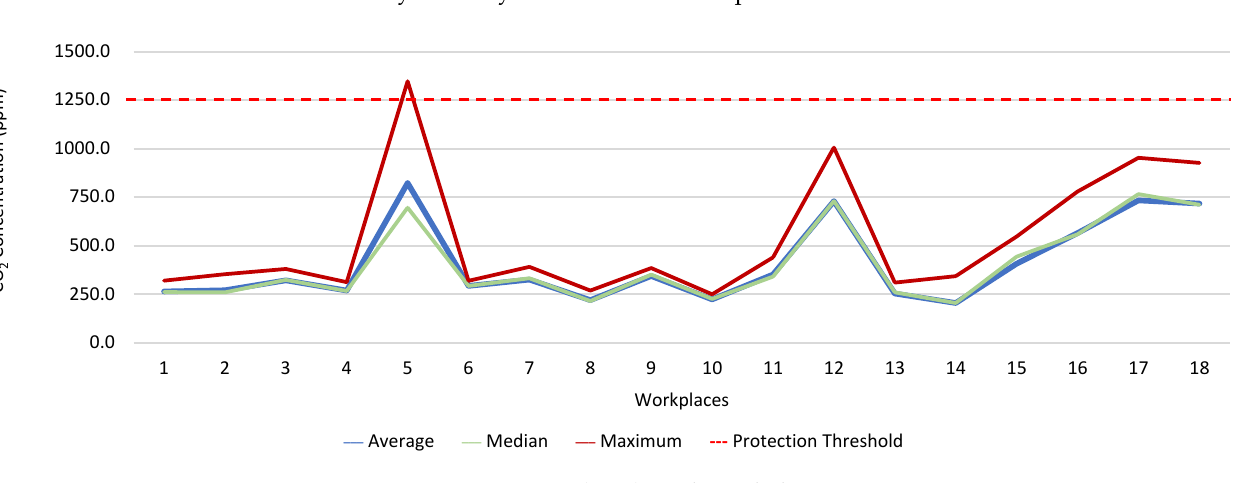
Figure 13. CO 2 concentration (ppm) inside workplaces.